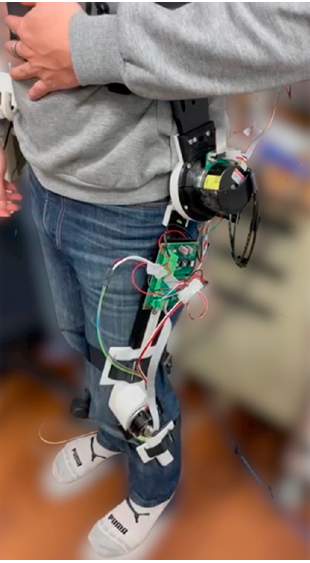
Figure 6. A subject wearing the robotic hip-knee exoskeleton.